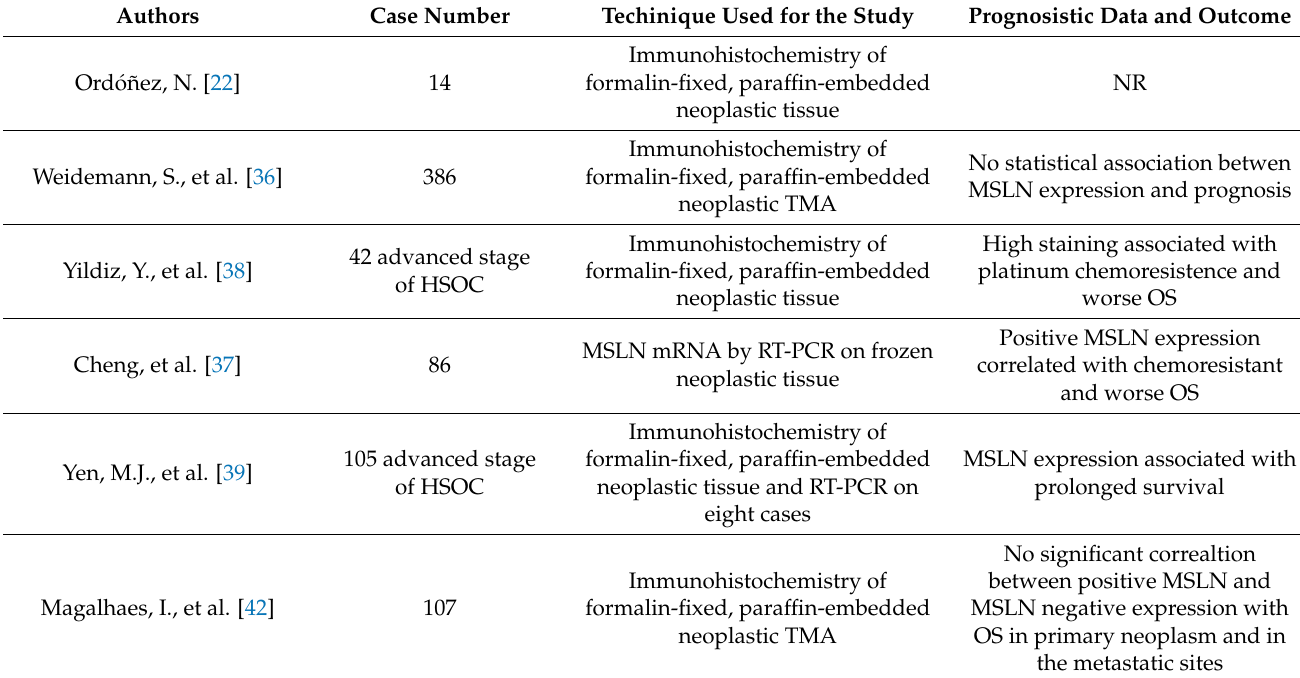
Table 1. Correlation between MSLN expression and prognosis in the main